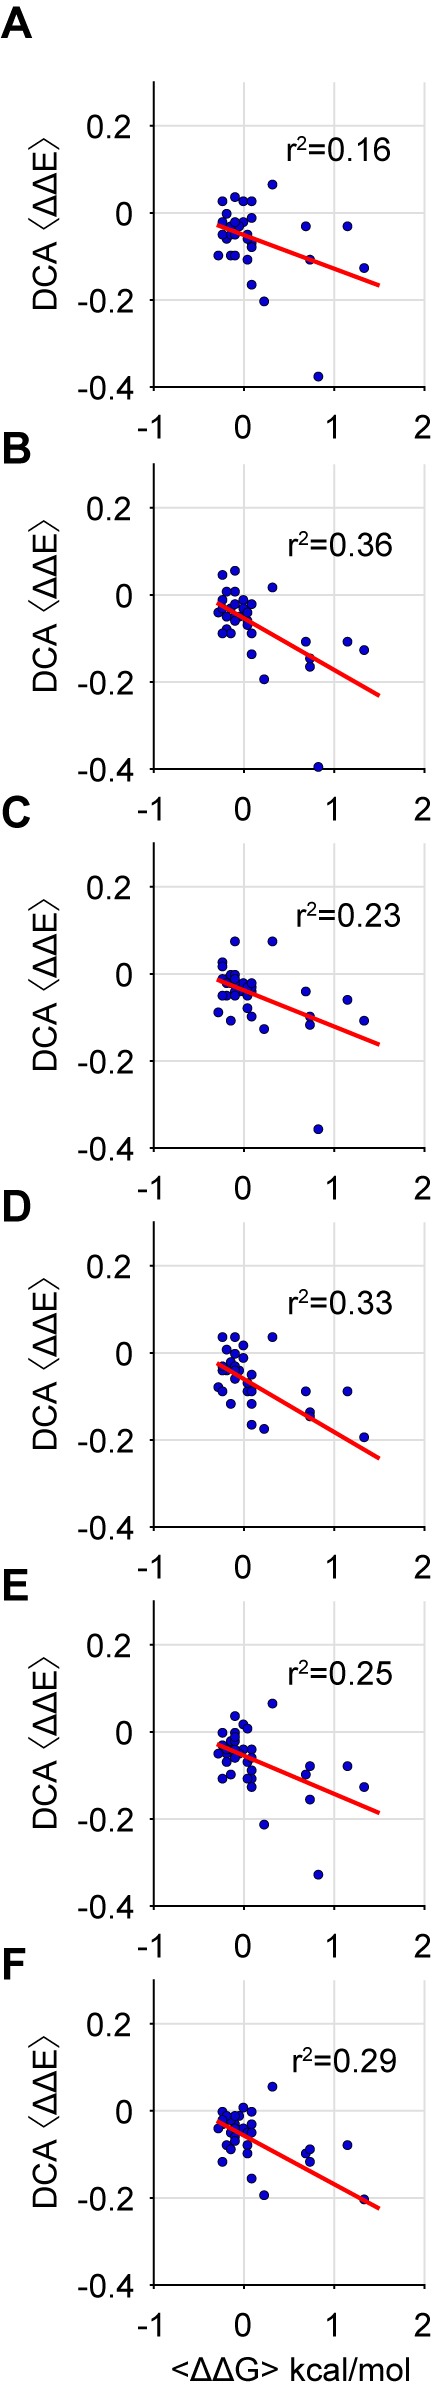
Robustness of DCA to alignment size.(A–F), The graphs show scatterplots of homolog-averaged experimental couplings in the α2 helix against computed DCA model coupling energies for six independent trials of randomly sub-sampling the Poole PDZ alignment (1656 seqs) to retain half the sequences. DCA expectedly shows more sensitivity to alignment size. The Poole alignment provides the best correspondence between experimental data and DCA and is therefore chosen for this analysis.